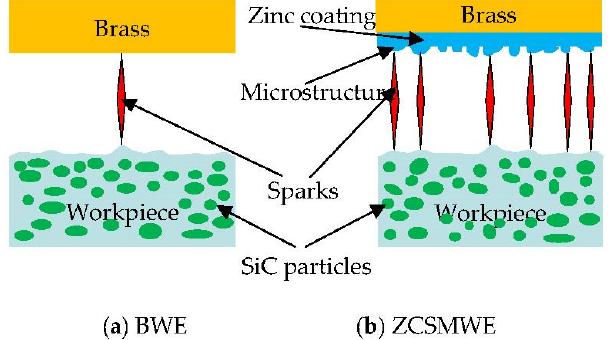
Figure 10. Depiction of the discharge condition by BWE and ZCSMWE.